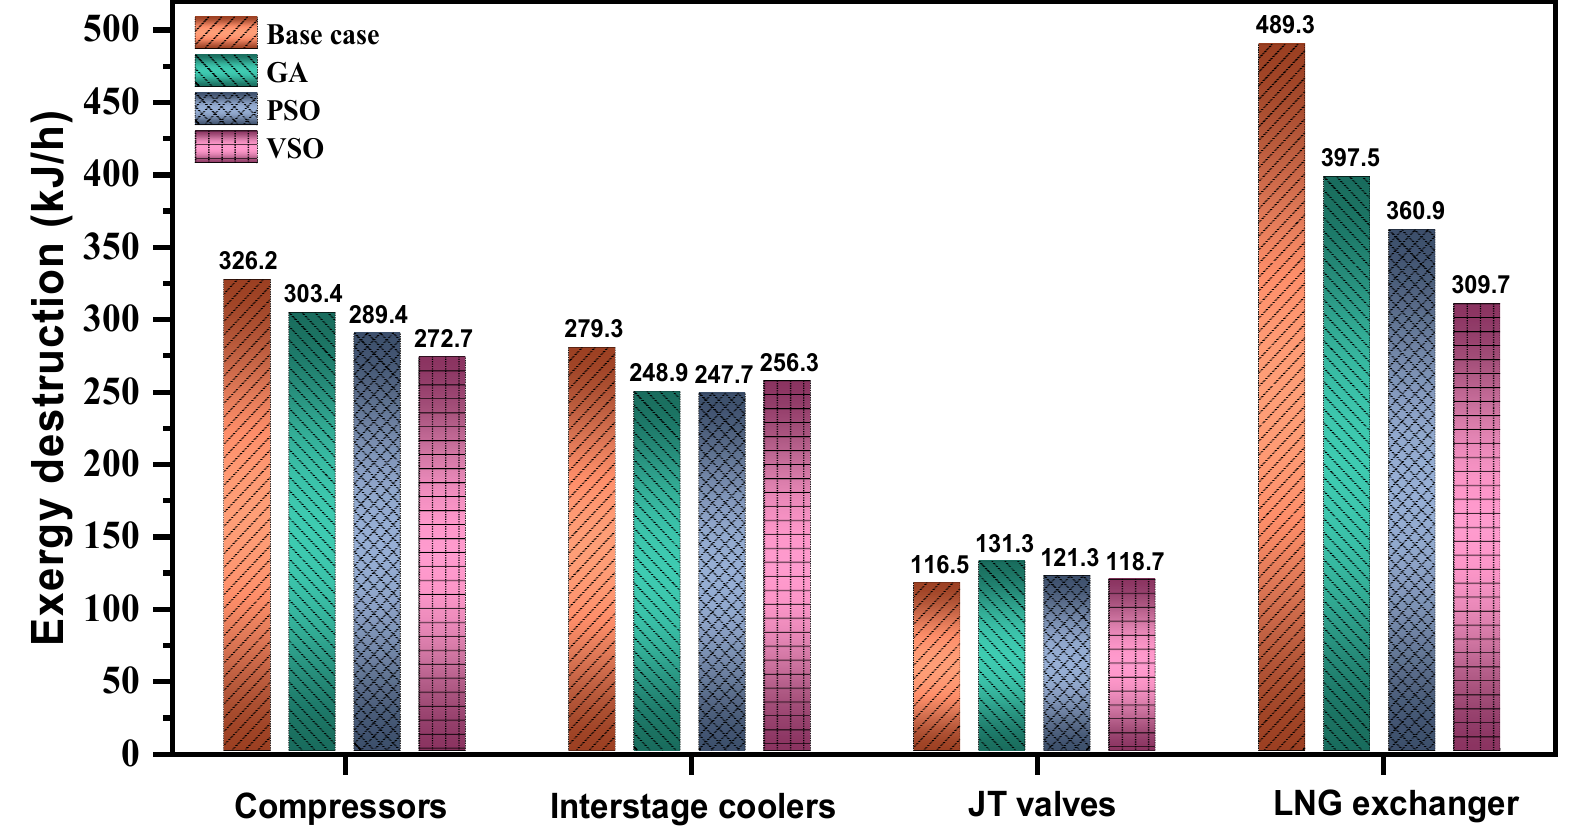
Figure 9. Exergy destruction associated with each equipment of the optimized SMR process.